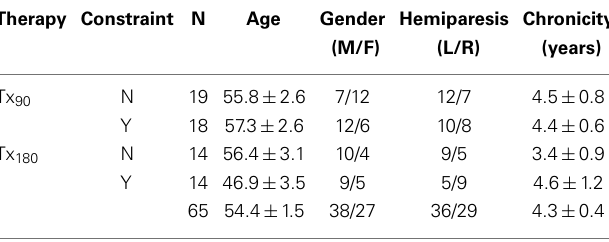
Table 1 | Demographic characteristics or the treatment groups .